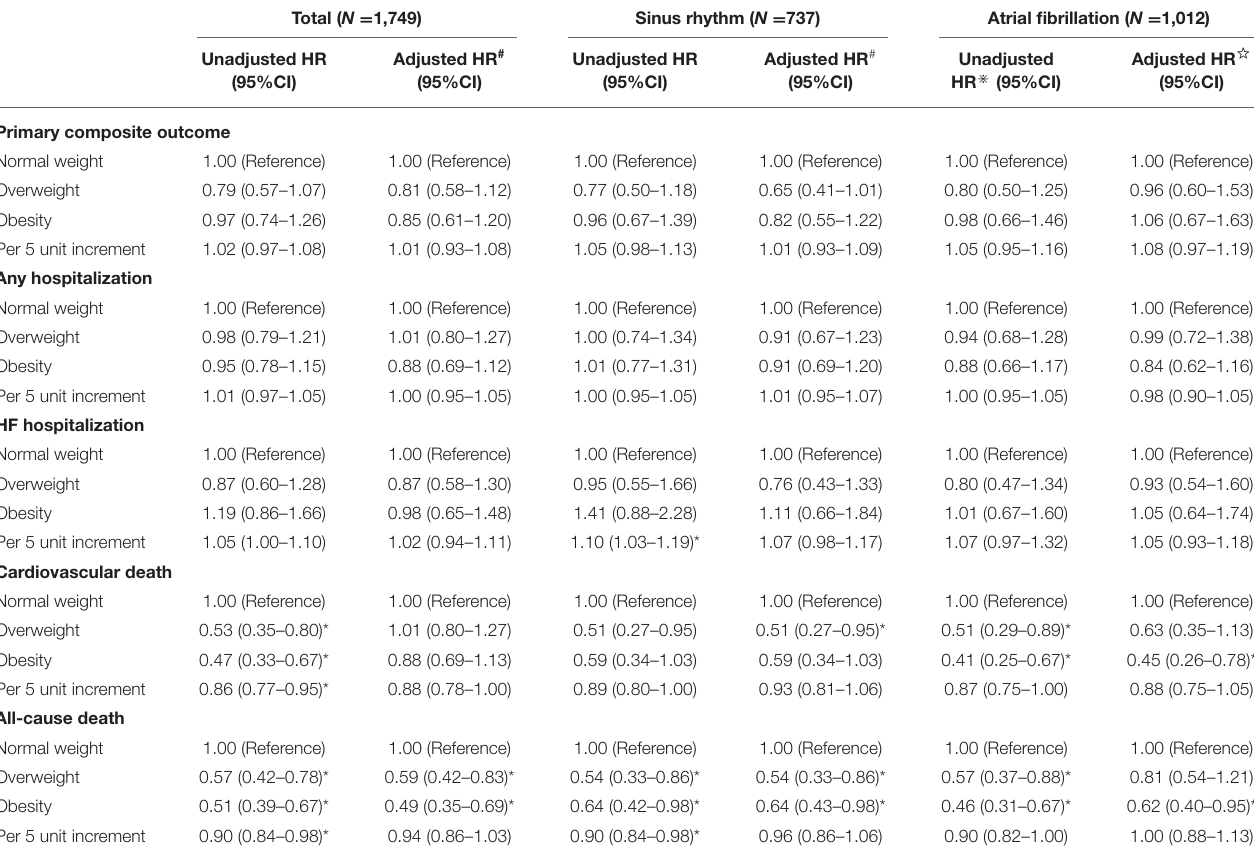
TABLE 2 | The univariate and multivariate Cox regression analysis for outcomes in patients with HFpEF by atrial fibrillation